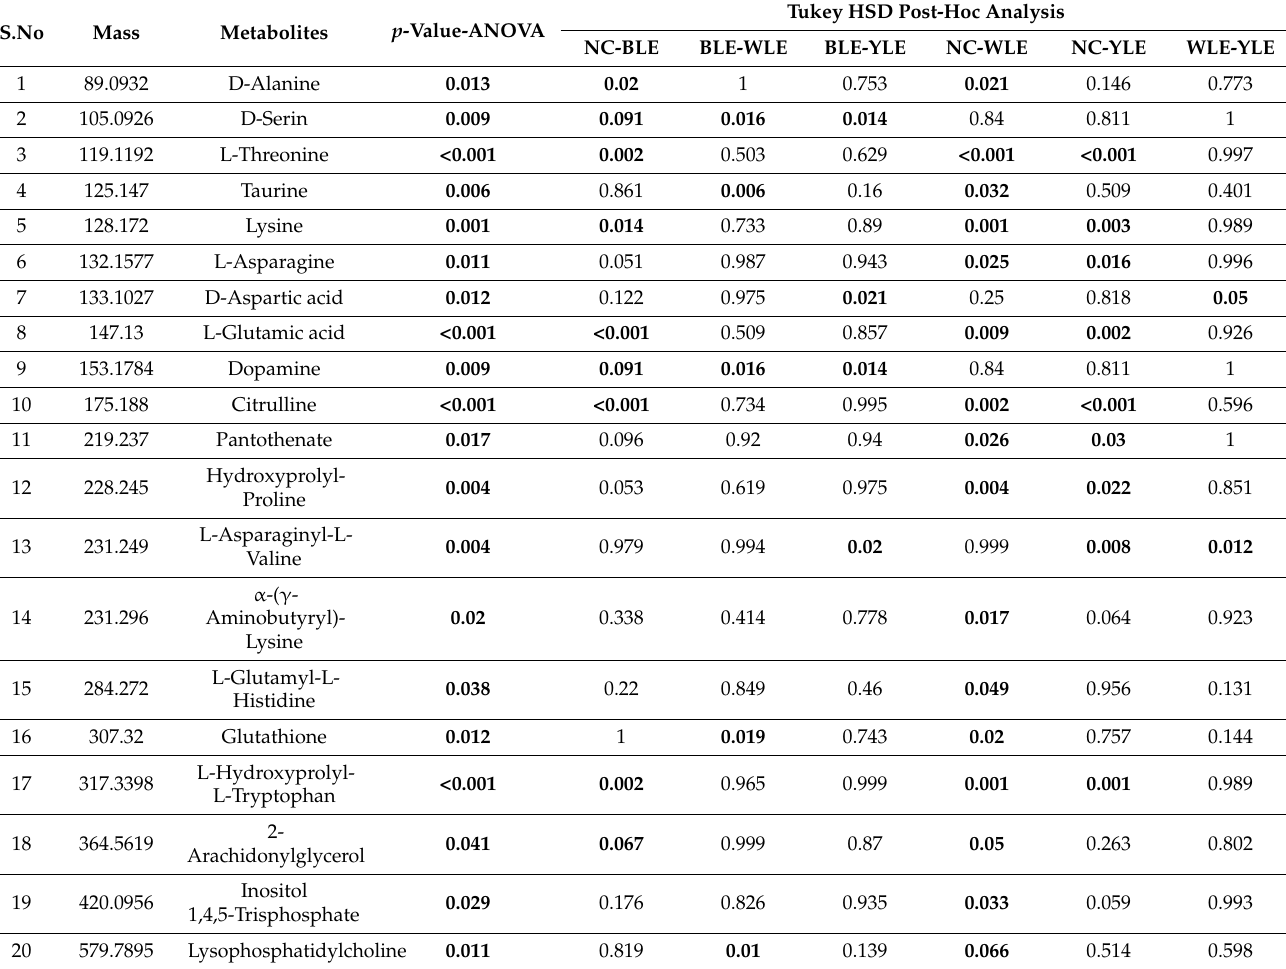
Table 1. Distinguish altered vitreous metabolites in NC, BLE, WLE, and YLE metabolite intensities of the most abundant and significantly altered amino acids, small molecules, and lipids detected in the vitreous of NC ( n = 6) BLE ( n = 6), WLE ( n = 6) and YLE ( n = 6). Statistically significant changes in metabolite intensity between the control and lens protection groups are represented by indicating ( p < 0.001, p < 0.01, p <